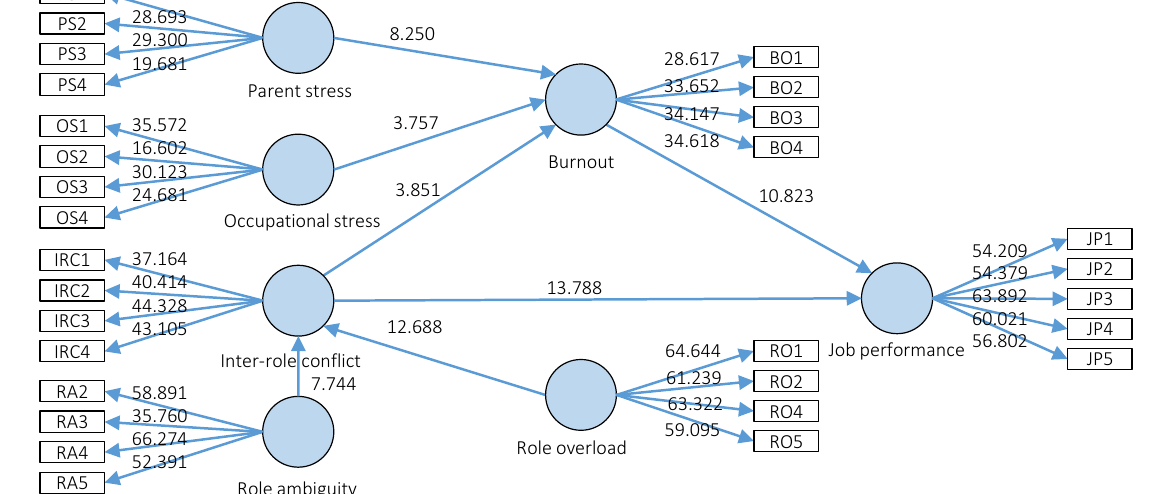
Figure 2. PLS-SEM